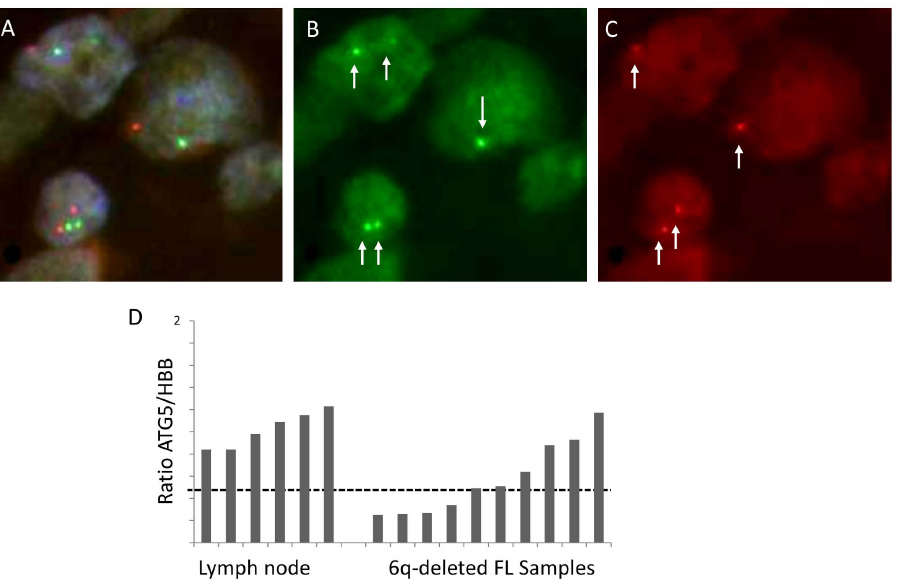
Figure 2. Comparison of FISH and qPCR in FL samples. Ten samples with detectable 6q-deletions as observed in chromosome banding (positive controls) were investigated by FISH (A–C) and by qPCR (D). FISH was performed with 6q21- (red) (ATG5) and 6cen-specific (green) BAC- clones. Representative overlay of Dapi-, SpectrumOrange (red: R) and SpectrumGreen (green: G) filters (A), either single SpectrumGreen (B) or SpectrumOrange (C) filter indicating different signal constellations (wildtype: 2R2G; 6q21-deletion: 1R2G; section artefact: 1R1G) (magnification: 100 6 ). Using the qPCR approach ten positive control samples were compared to five reactive lymph node specimens (D) (here referred to HBB as internal control). For the qPCR approach, the cut-level obtained is indicated as dashed line. Although these samples clearly harboured deletions in the chromosomal band 6q21 (including the ATG5 -locus) as observed by FISH and chromosome banding, in only four of ten 6q-deleted FL samples loss of the ATG5 -gene was detected by qPCR.